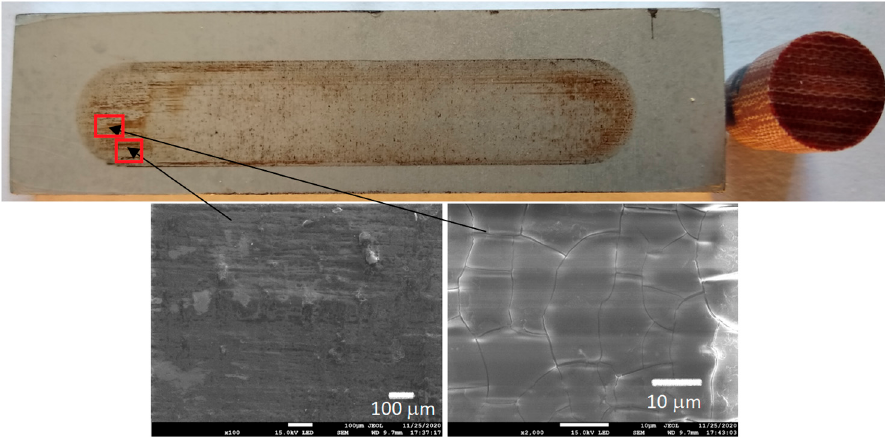
Figure 10. Photographs and SEM micrographs of Al 2 O 3 /IF-WS 2 tribological pairs after a tribological test with PF + cotton.